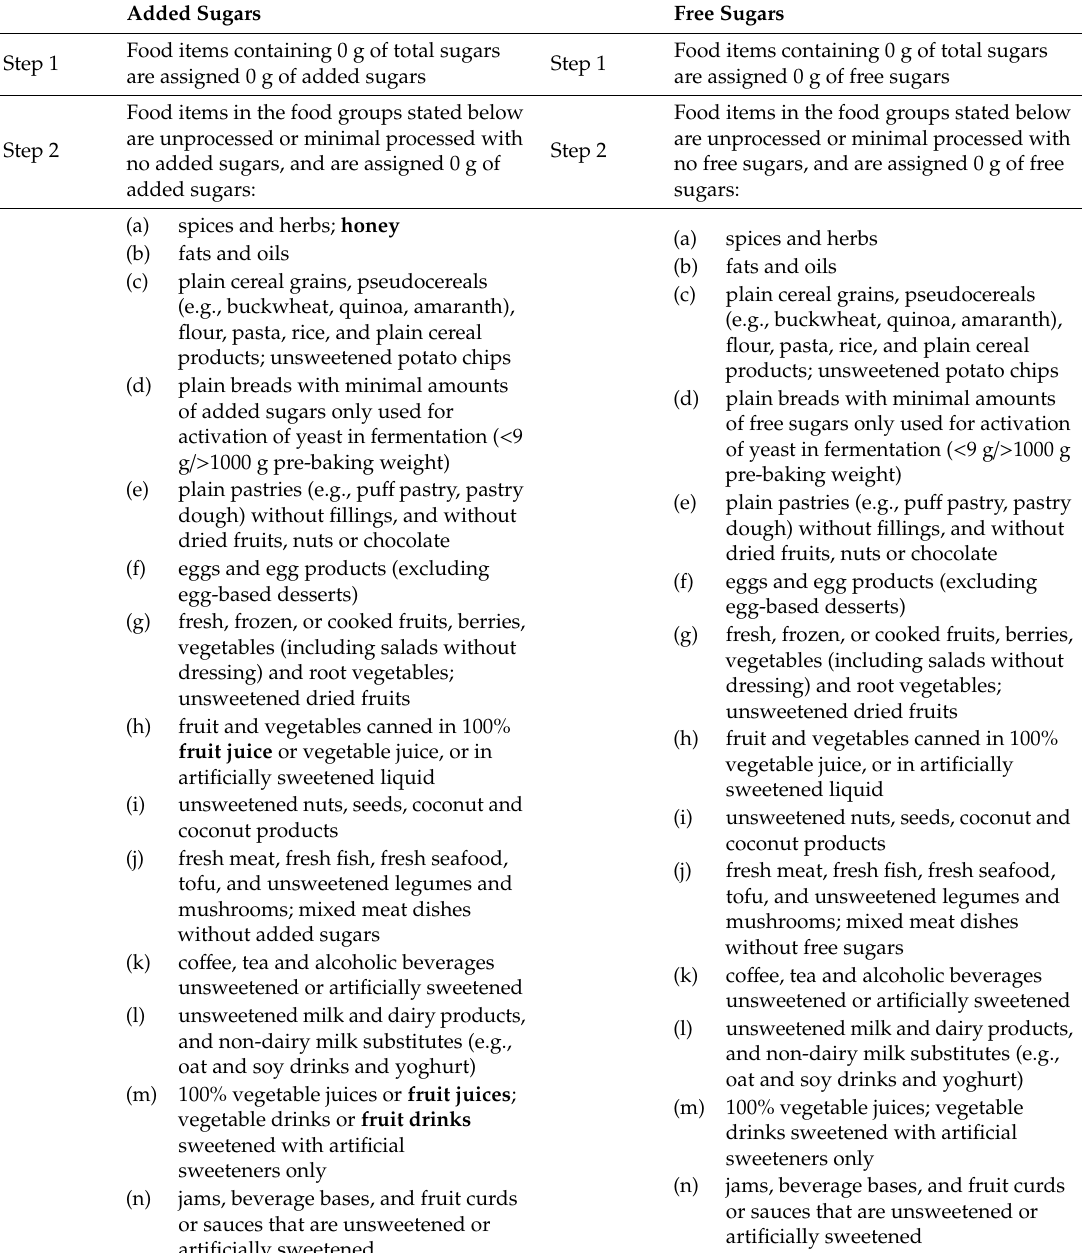
Table A1. Detailed ten-step decision-making procedure for estimating added and free sugars